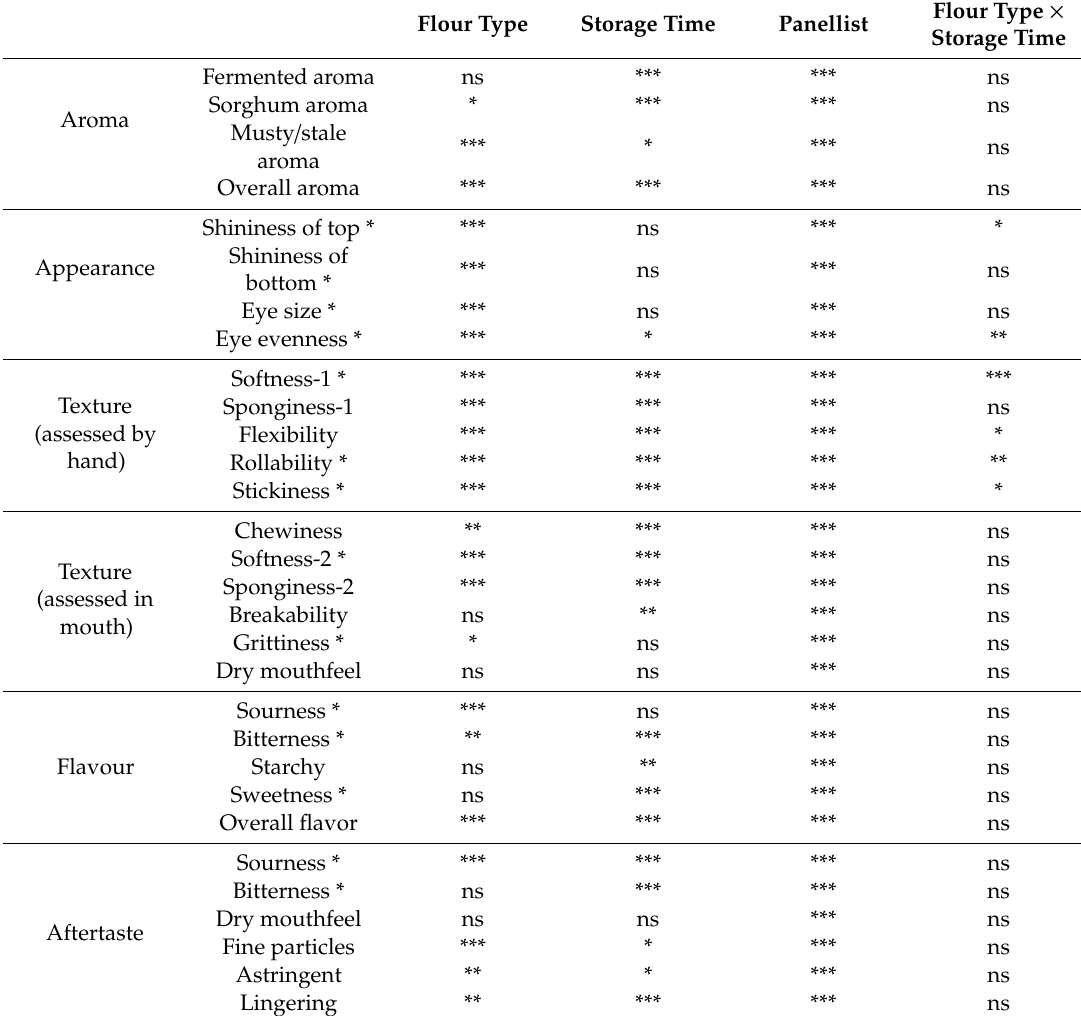
Table 3. Summary of main and interaction e ff ects on the sensory attributes of injera and their level of statistical